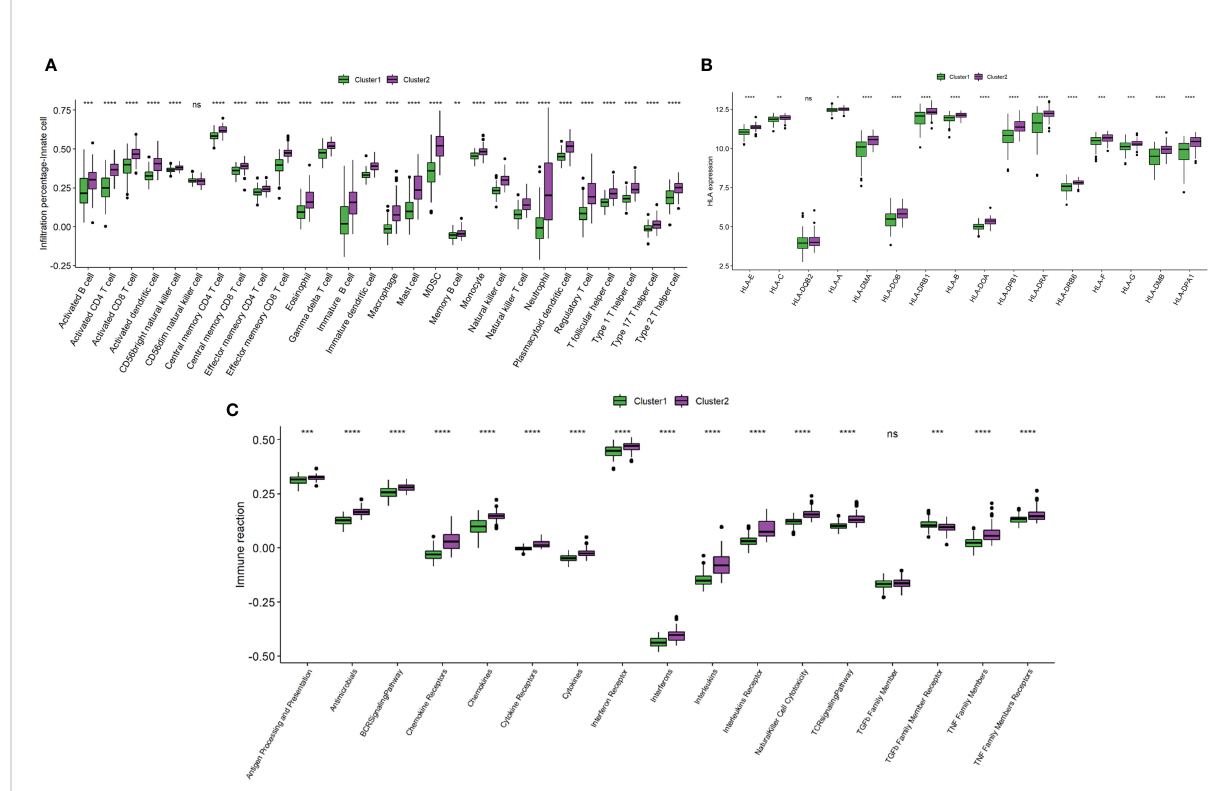
FIGURE 9 Comparison of immune microenvironment between clusters. (A) Box plot showing immune cell in fi ltration levels in two clusters. (B) Box plot demonstrating HLA expressions in two clusters. (C) Box plot illustrating immune reaction in two clusters. ns: P ≥ 0.05; *: P < 0.05; ** P ≤ 0.01; *** P ≤ 0.001; **** P ≤